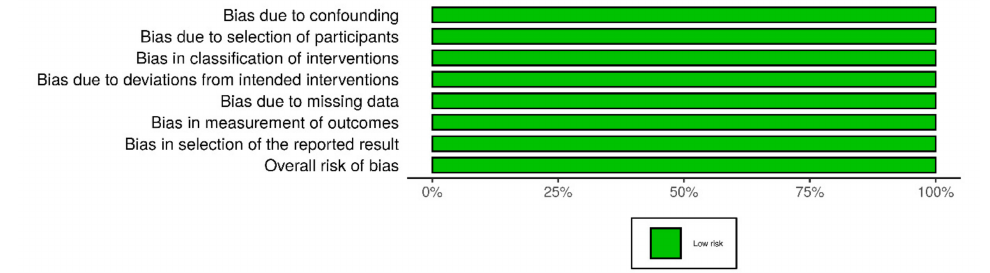
Figure A3. Risk of bias weighted summary plot: review authors’ judgements about each risk of bias item presented as percentages across all included non-randomized studies.